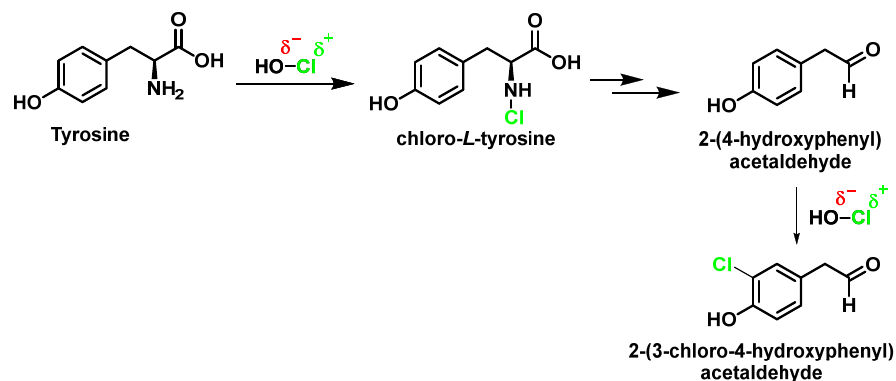
Figure 25. Formation of p-hydroxyphenylacetaldehyde [77] and 3-chloro-4-hydroxyphenylacetal-